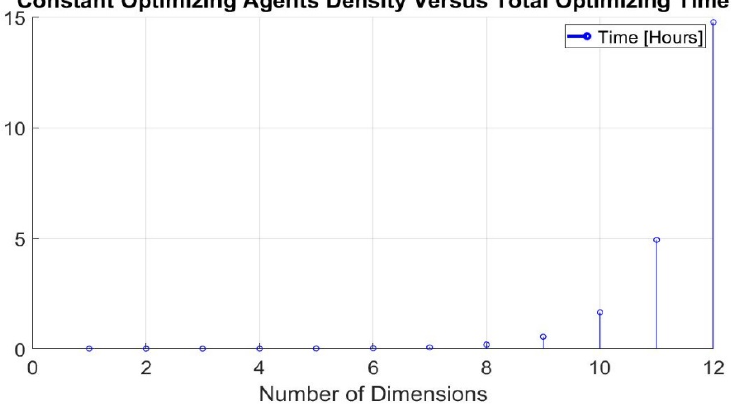
Figure 19. Maintaining a constant optimizing density of 3 agents per axis versus total optimizing time. In this case, a significant increase in optimizing time occurs for a linear increase in the number of particles, limiting the number of variables that can be optimized. Simulation time is 0.1 s, while the total time is shown for one single iteration of PSO.